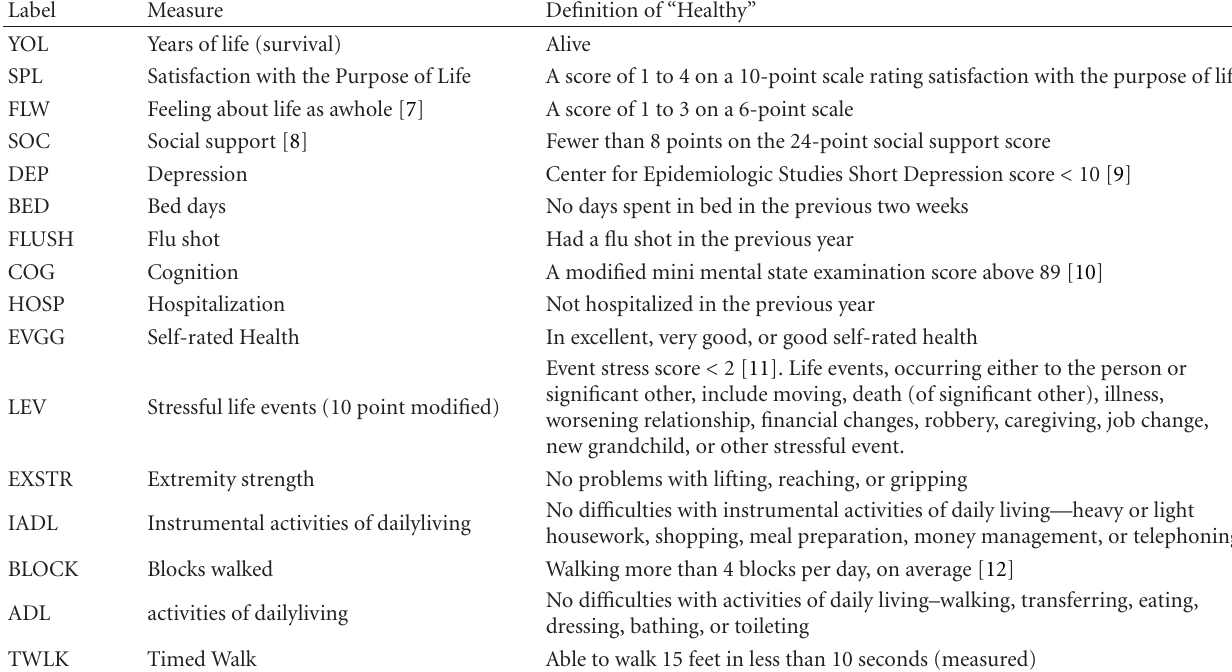
Table 1: Definitions of “healthy” based on 16 health-related